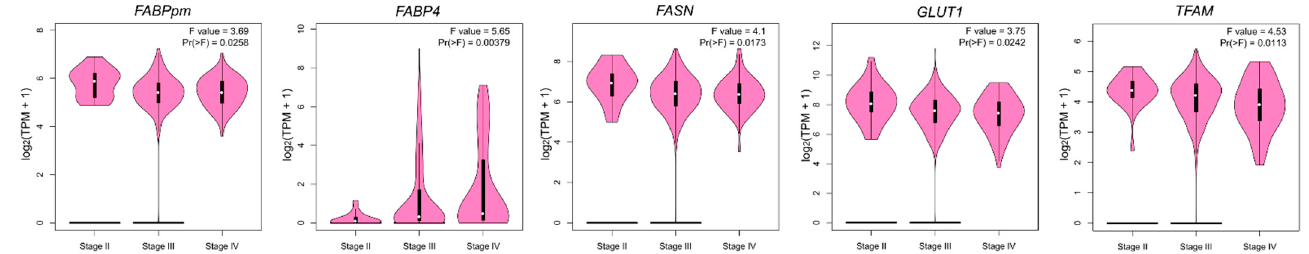
Figure 6. Violin plots representing significant correlations ( p < 0.05) between gene expression and clinical stage based on the TCGA-OC dataset.